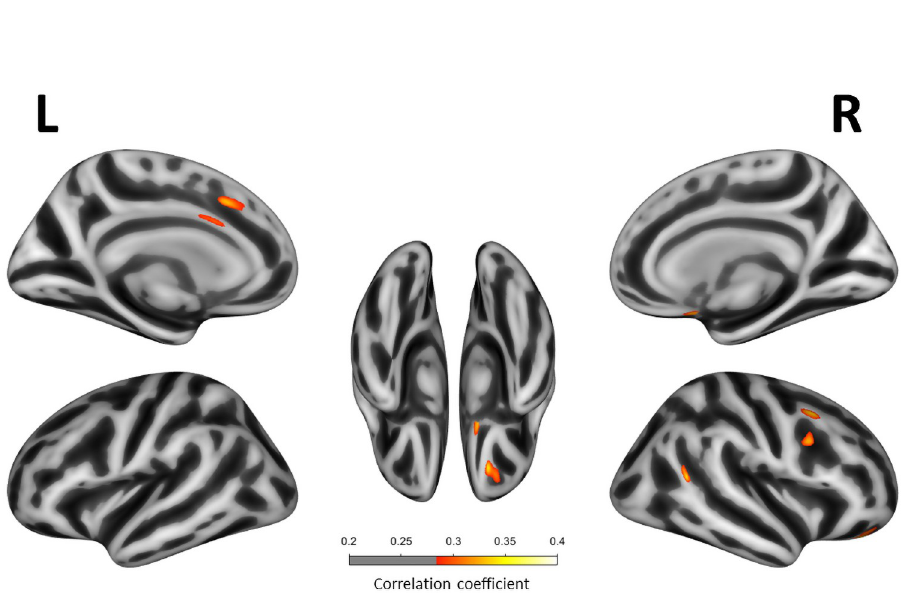
Fig 2. Correlation between Insomnia Severity Index scores and cortical thickness. Correlation between ISI scores and cortical thickness in all participants (n = 120). Only regions with P -value < .001 (uncorrected FWE) are shown. All multivariate linear regression models were adjusted for age, sex, handiness and scan type. Correlation coefficients are expressed as a color scale, indicating an increasing strength of the correlation from red to yellow.